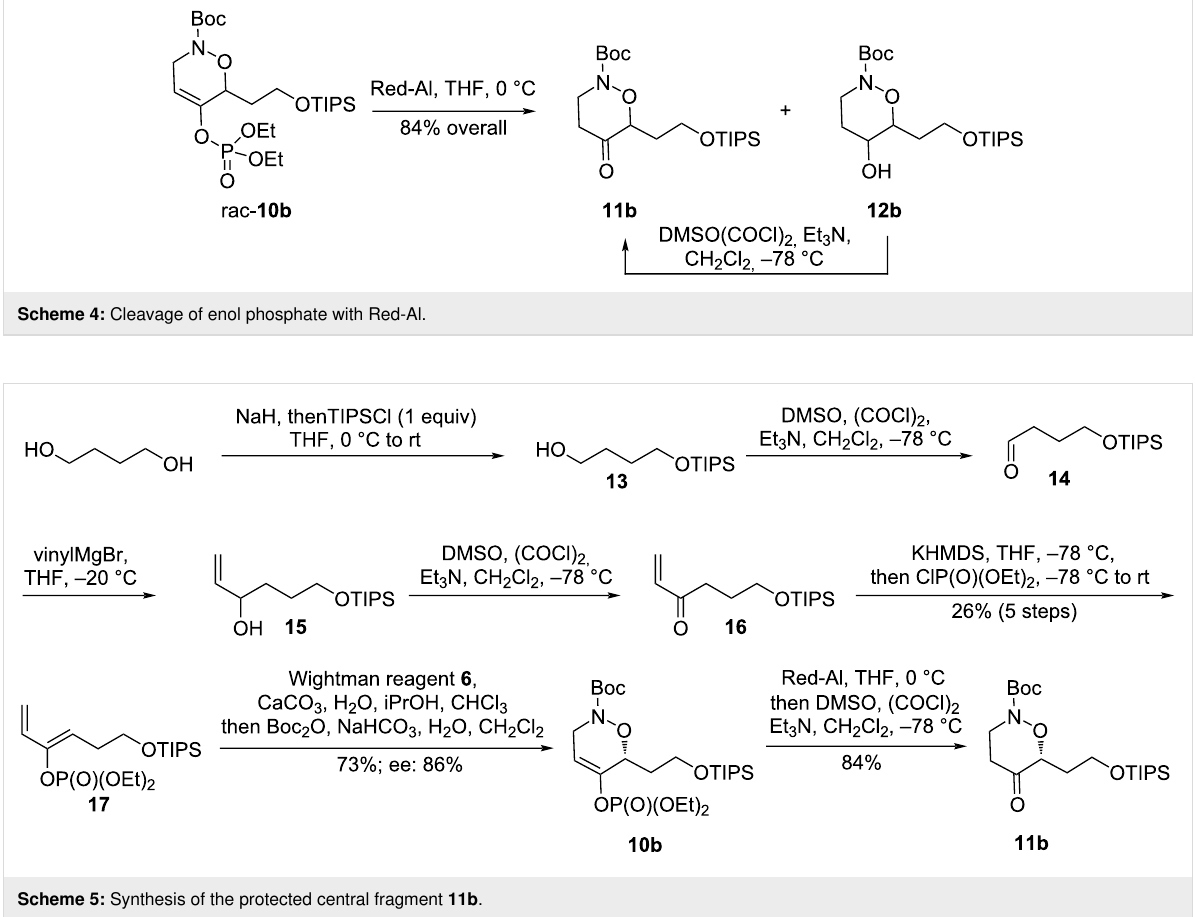
Scheme 5: Synthesis of the protected central fragment 11b